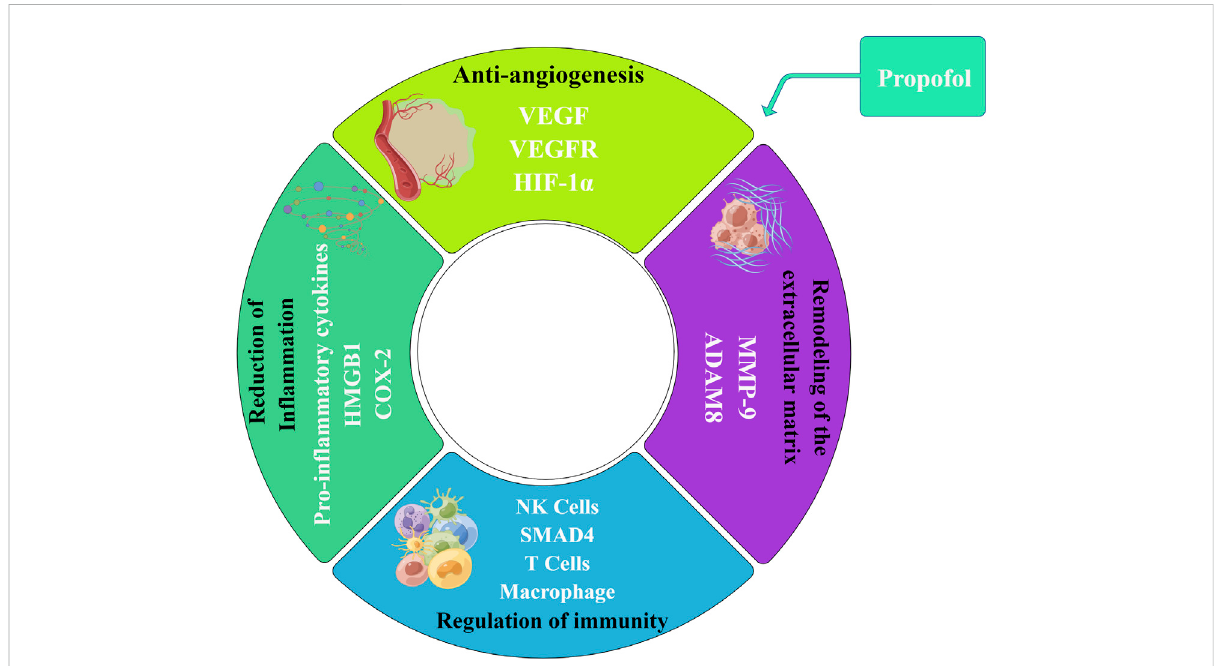
FIGURE 5 Effect of propofol on the tumor microenvironment. Propofol can play a role in reshaping the tumor microenvironment, including anti- angiogenesis, regulation of immunity, reduction of in fl ammation, and remodeling of the extracellular matrix, indirectly affecting the biological characteristicsoftumorcells.PropofolcaninhibittheexpressionofVEGF/VEGFRandplayananti-angiogenesisrole.Propofolregulatesimmunityby affecting the in fi ltration and activity of a variety of immune cells, such as T cells, NK cells, and macrophages. Propofol can reduce in fl ammation via inhibiting the release of pro-in fl ammatory cytokines and targeting the expression of HMGB1 and COX-2 in fl ammatory proteins. In addition, propofol can target the expression of MMP-9 and ADAM8 to remodel the tumor extracellular